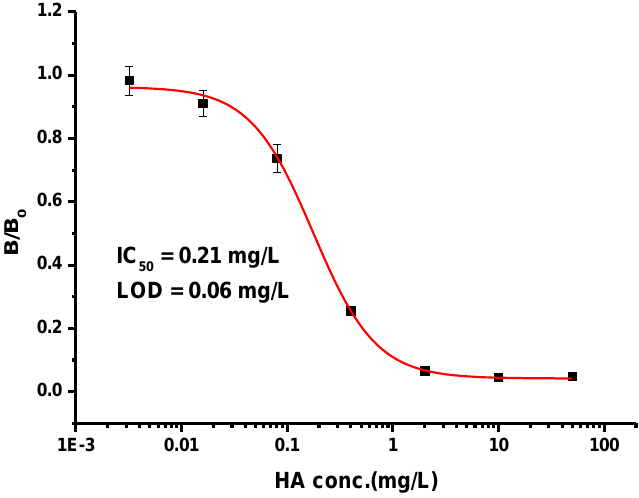
Figure 4. Anti-HA Mab based ic-ELISA calibration curve for HA ( n = 3).